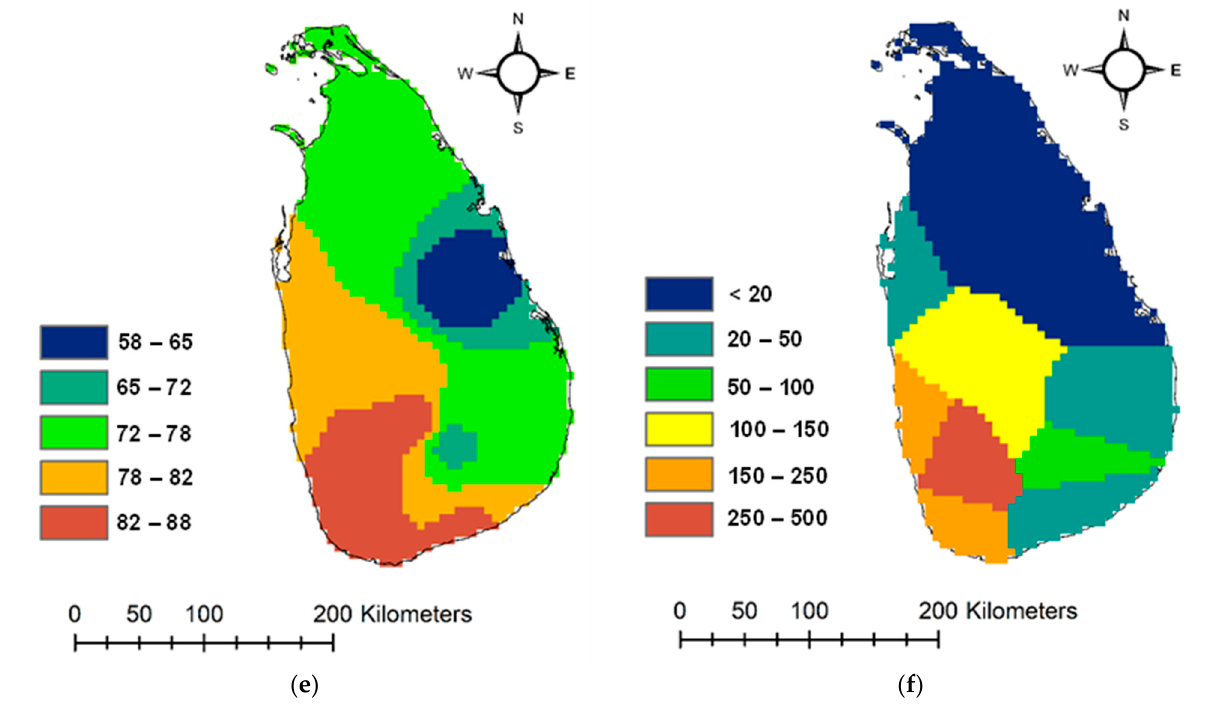
Figure 2. Thematic layers of meteorological data in June (averaged from 2009 to 2019) and spatial data: ( a ) elevation (m); ( b ) mean temperature ( ◦ C); ( c ) wind speed (km/h); ( d ) net solar radiation (MJ/m 2 ); ( e ) relative humidity (%); ( f ) rainfall (mm).